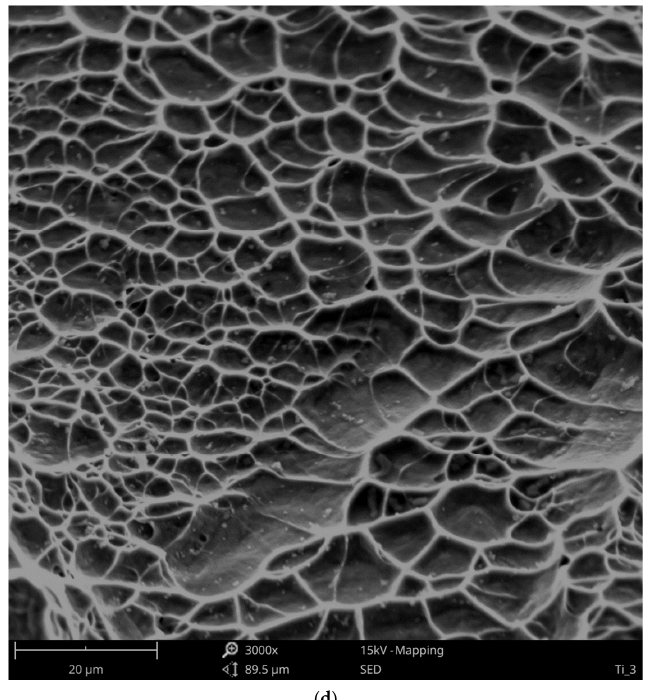
Figure 14. Fracture morphology ( a ) of the titanium weld joint obtained after monotonic loading under different magnifications; ×500 ( b ), ×1000 ( c ), ×3000 ( d ).